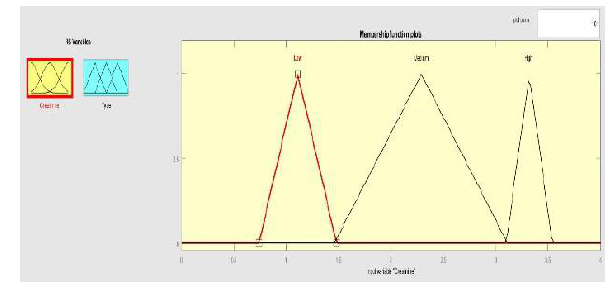
Fig. 4. Newly constructed MFs for creatinine